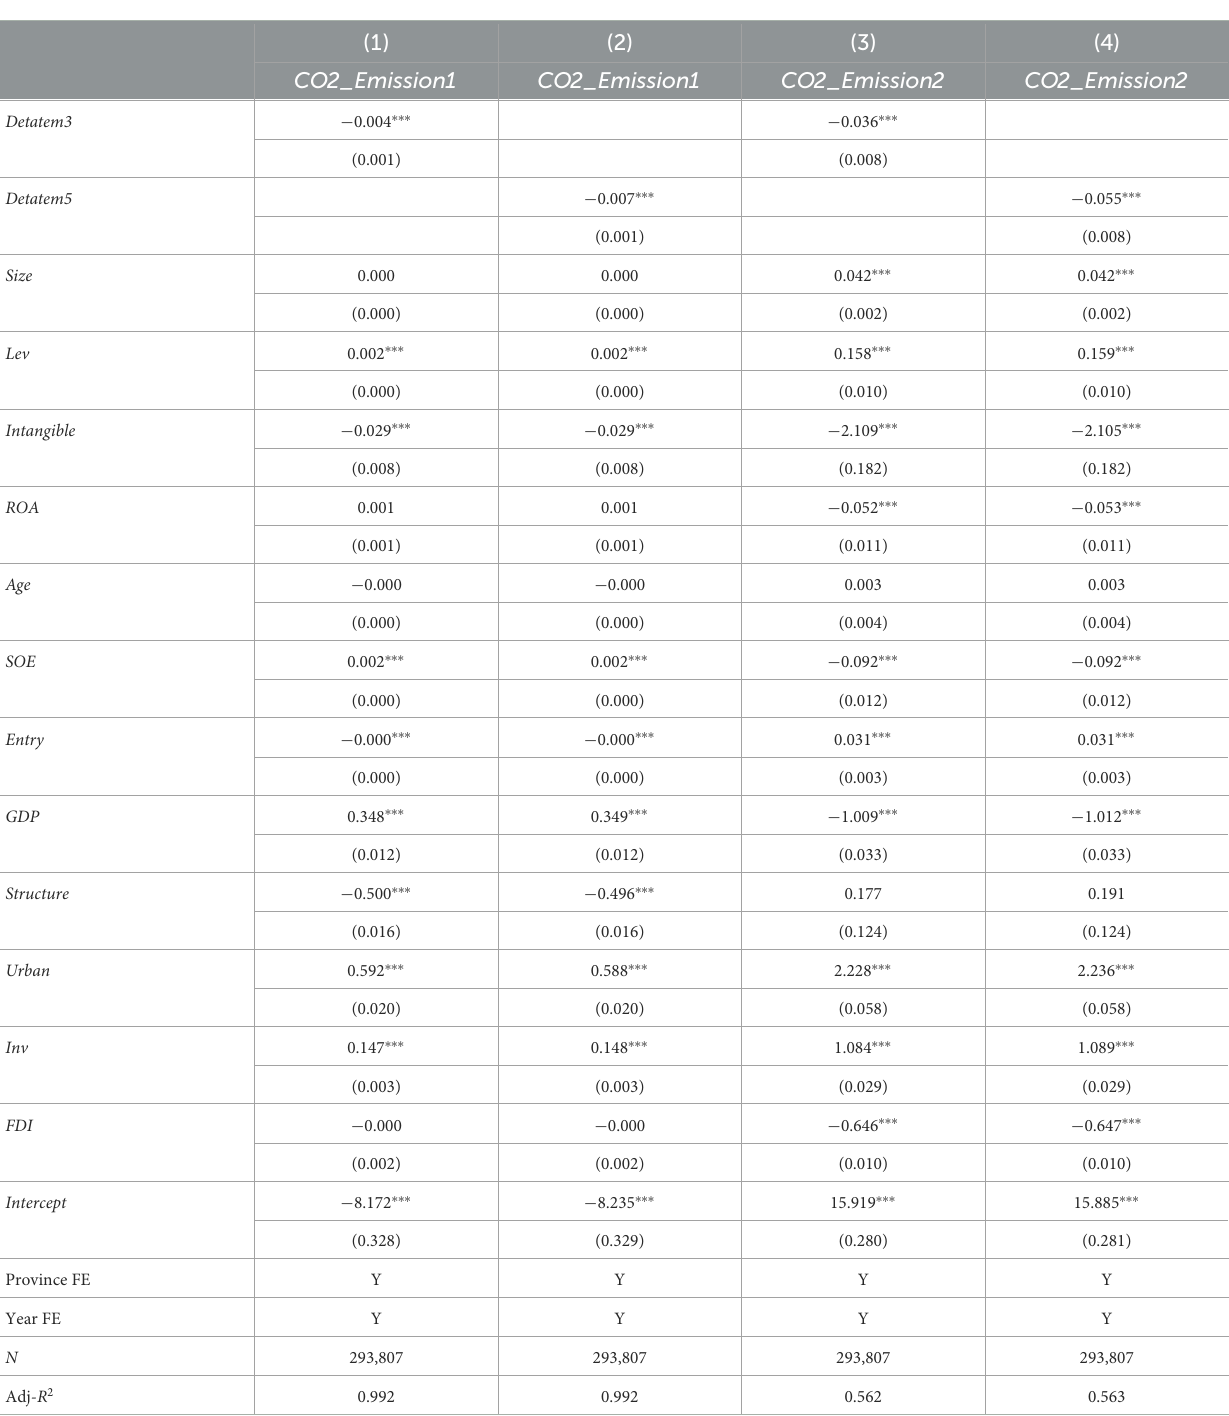
TABLE 8 Climate change and CO2 emissions at the province